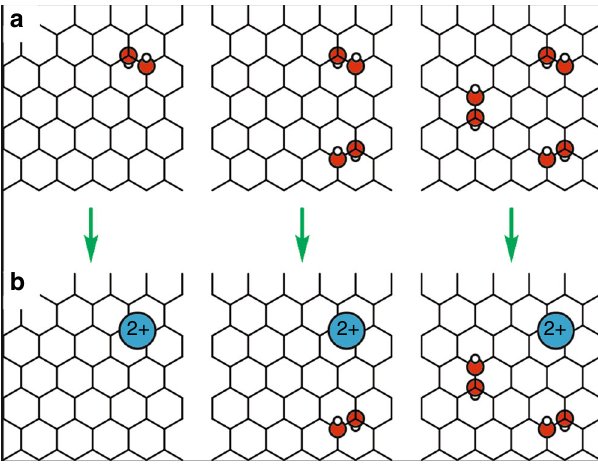
Fig. 5 Sketch of spontaneous dehydroxylation events for different OH coverages. a Initial con fi gurations, b result after 40 ps of ab